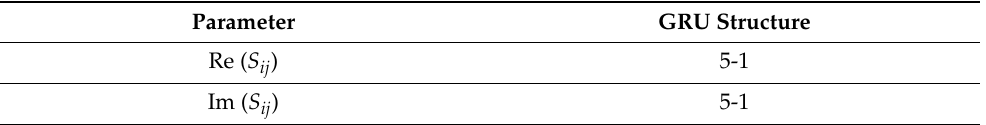
Figure 5. Illustration of the internal architecture of a GRU unit. The symbols “ ⨁ ” and “ ⨂ ” represent the operation of addition and element-wise multiplication, respectively. Table 2. Structure of the trained GRU: size of the GRU layer and the dense layer.